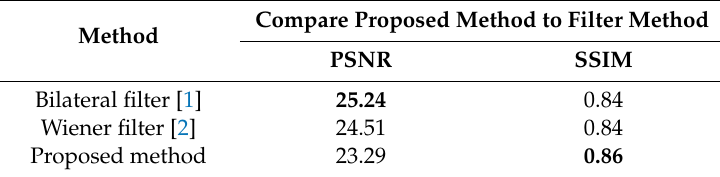
Table 2. PSNR and SSIM on Kohler